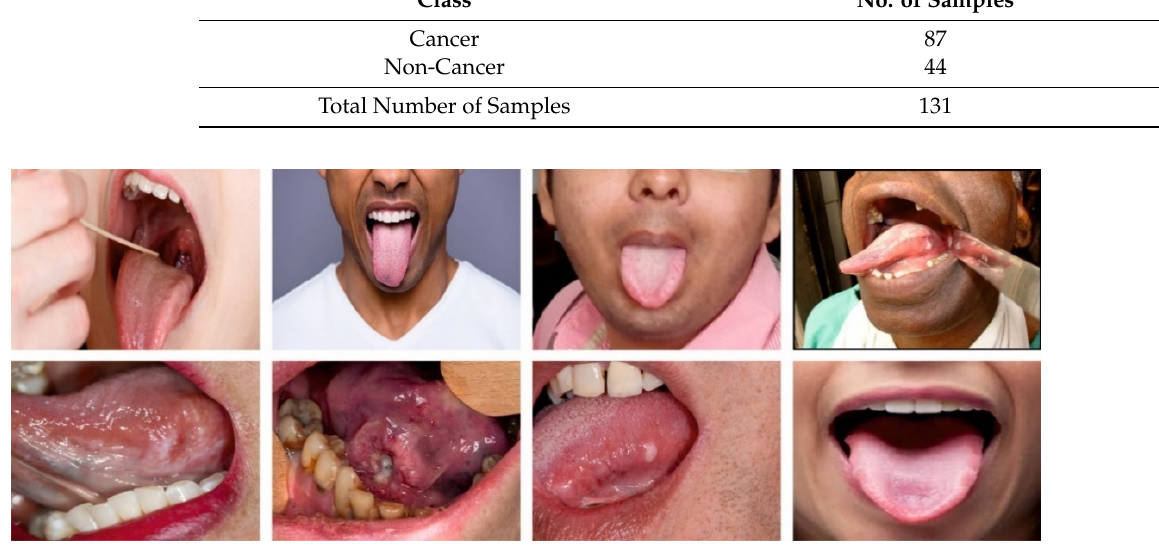
Figure 2. Sample